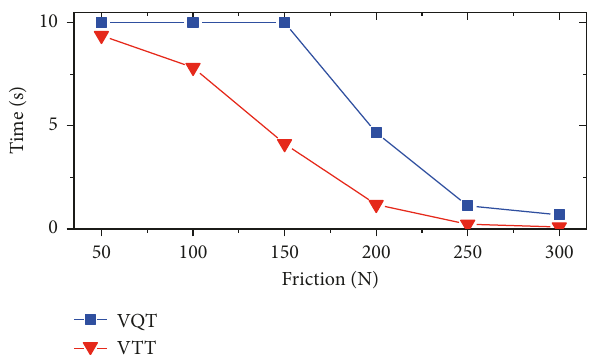
Figure 20: Vibration quit time and vibration total time of rod 2 with different frictions ( c � 2.5, F